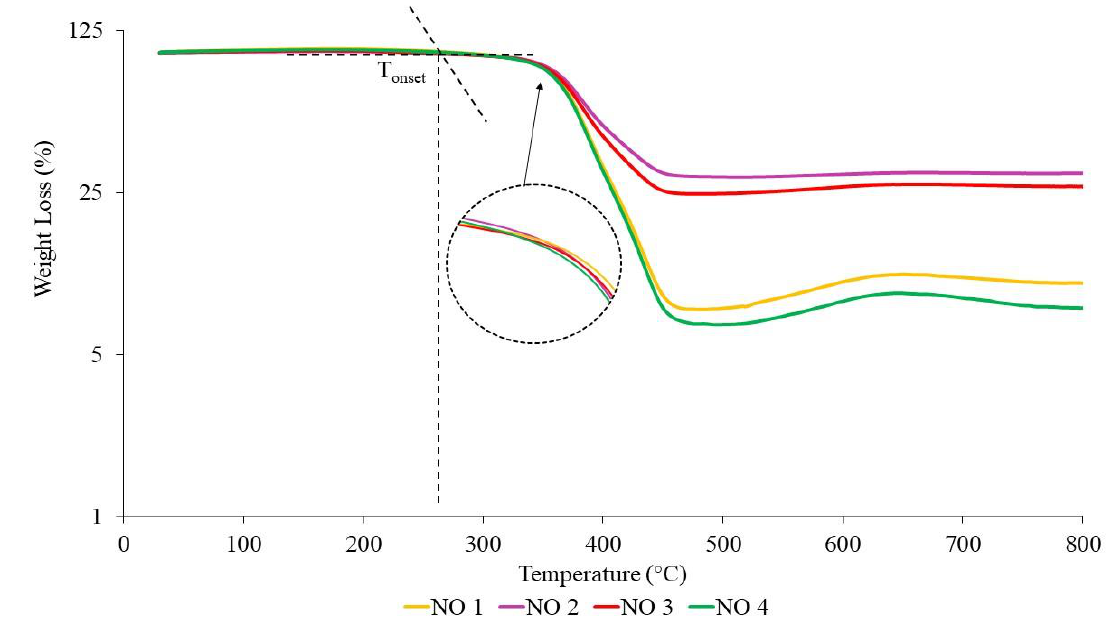
Figure 10. TGA curves of NR-based MREs for different ratios of NO:AO.